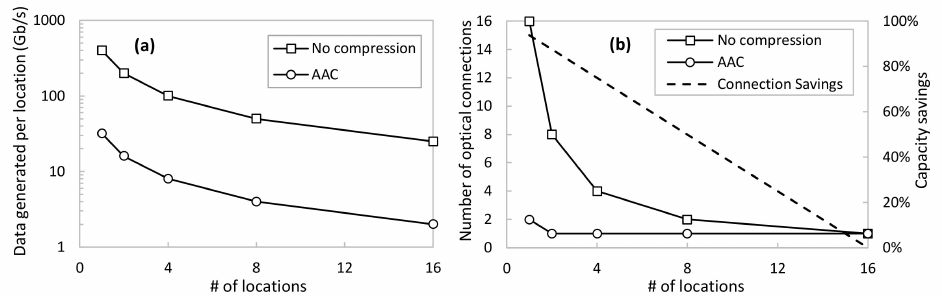
Figure 10. Network study analysis: data generated ( a ) and number of optical connections ( b